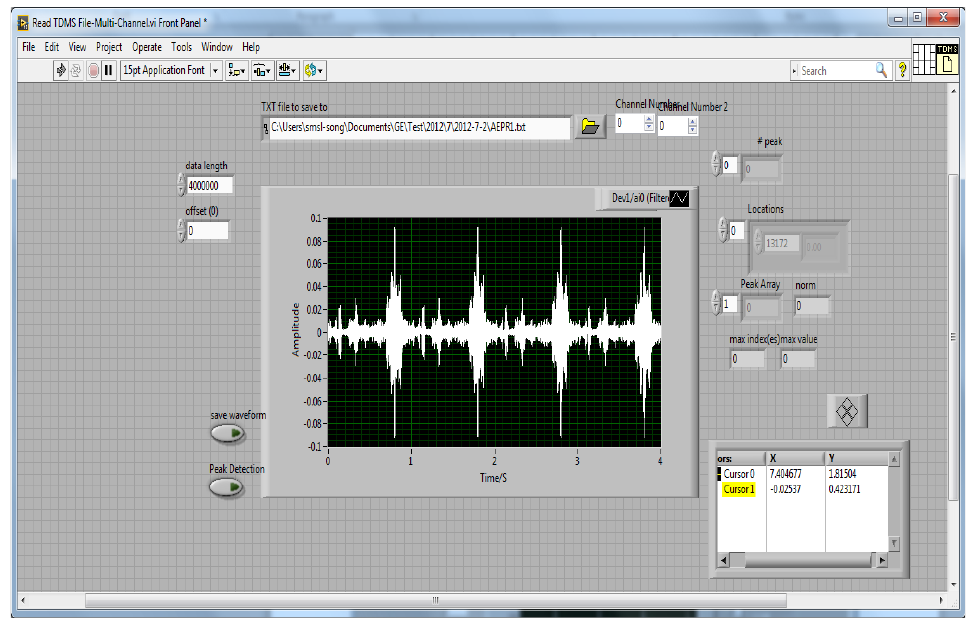
Figure 7. TDMS file run in LABVIEW software.